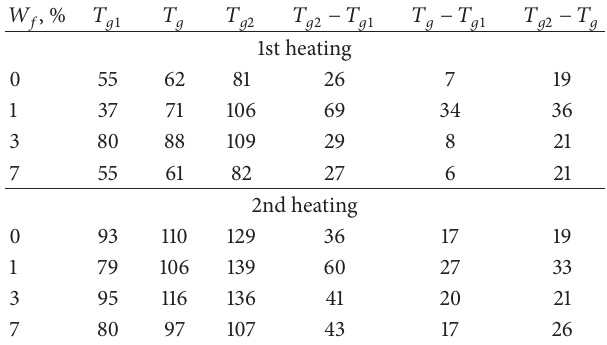
Table 3: The values of 𝑇 𝑔 , initial 𝑇 𝑔1 , and final 𝑇 𝑔2 of the glass- transition process for the PU/OMMT